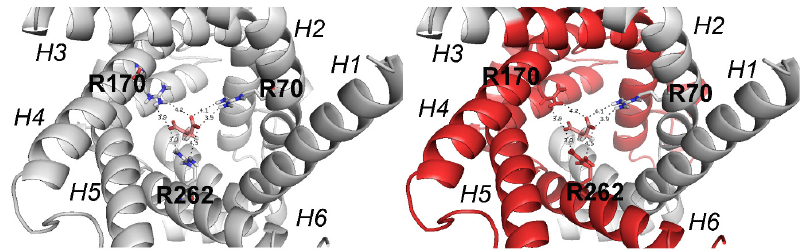
Figure 6. The structure of the SLC25A10 protein is reported in cartoon representation. The three arginine residues forming the three contact points of DIC, in the similarly located MC binding region shared by all eukaryotic organisms hosting mitochondria [43,176–180], are reported in stick representation and labeled. The red color in the cartoon representation in the right panel indicates the protein region (including transmembrane helices H3-H6) that is not translated due to the premature stop codon